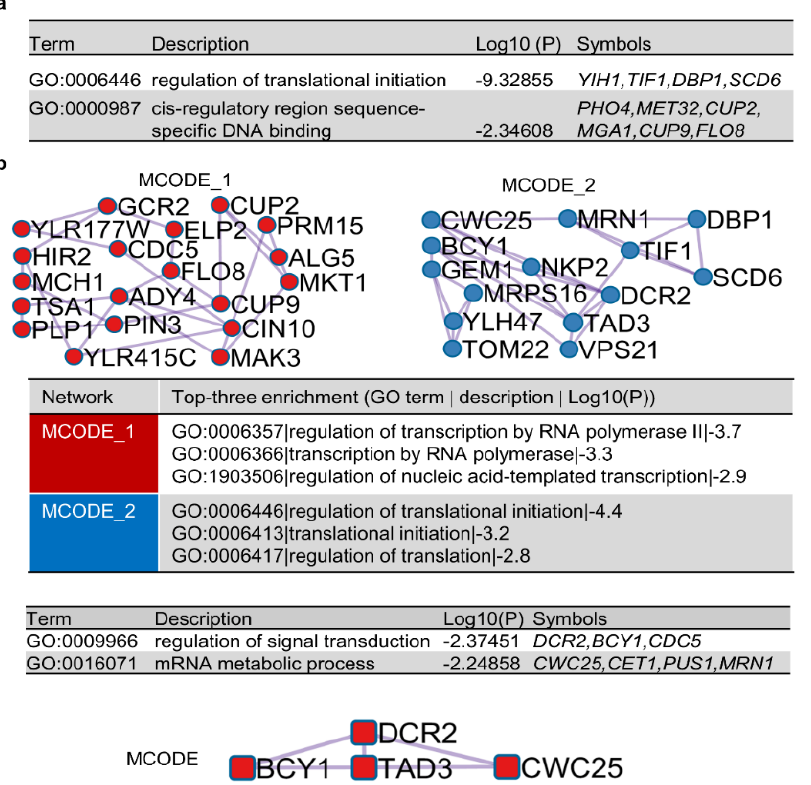
Figure 5. ( a ) Biological Processes (BP) enrichment of GO terms for the 82 primary hits; ( b ) protein– protein interaction (PPI) networks identified for the 82 hits. Enriched GO terms (BP) assigned for each molecular complex detection (MCODE) are shown at the bottom; ( c ) BP enrichment of GO terms for the top 15 anti-[ SWI + ] proteins with faster curing kinetics; ( d ) a PPI network (MCODE) was identified among the 15 top suppressors. No enrichments were identified for 23 slow [ SWI + ] destabilizers. Analyses in this figure were performed with Metascape (see Methods for details). Considering that downregulation of SWI1 expression may lead to a decrease in Swi1 monomer production and thus cause prion loss, we examined whether downregulation of SWI1 transcription was one outcome of concerted actions of the identified diverse tar- gets. To test this possibility, 149 SWI1 regulators were retrieved from SGD, 14 of which are SWI1 transcriptional repressors. However, none of these SWI1 repressors were found among the identified 82 hits, suggesting that downregulation of SWI1 transcription was unlikely a prion curing mechanism for these identified hits. Another possible [ SWI + ]-cur- ing mechanism could be a competition for Swi1 monomer between [ SWI + ] aggregates and Swi1-interacting proteins. In this regard, 332 SWI1 interactors were retrieved from SGD, and 4 of them (Flo8, Elp2, Tad3, Alg5) were among the identified hits. Although there is no evidence to show such interactions are physical according to data from SGD, the over- production of these interactors may indirectly sequester the Swi1 monomer away from the prion aggregates because of the elevated engagement of the SWI/SNF complex. As a result, the competition may limit Swi1 monomers to join [ SWI + ] aggregates, promoting Swi1 toward its functional pathway and thus causing prion loss.